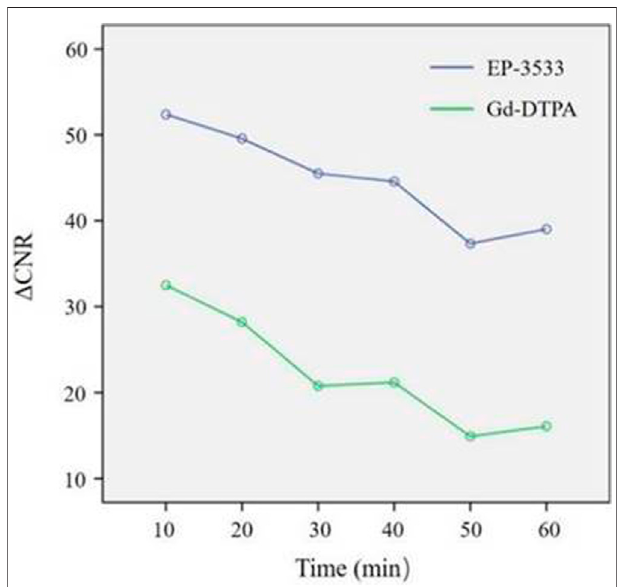
FIGURE 4 | Change in Δ CNR of the bowel wall according to the time stream after the administration of EP-3533 and Gd-DTPA. The bowel contrast-to-noise ratio(CNR) wascalculated asthedifference inthesignal-to- noise ratio between the bowel and muscle ROIs. The time dependence of the change in CNR ( Δ CNR (cid:2) CNR post – CNR pre ) following contrast agent injection was determined using dynamic MR